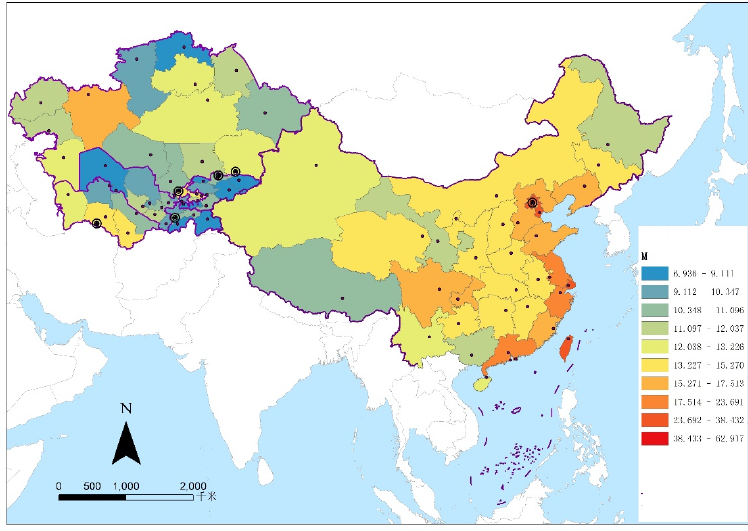
Fig. 2 Regional scale index of China and five Central Asian